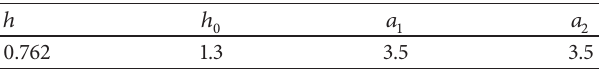
Table 2: The parametric dimensions of the element